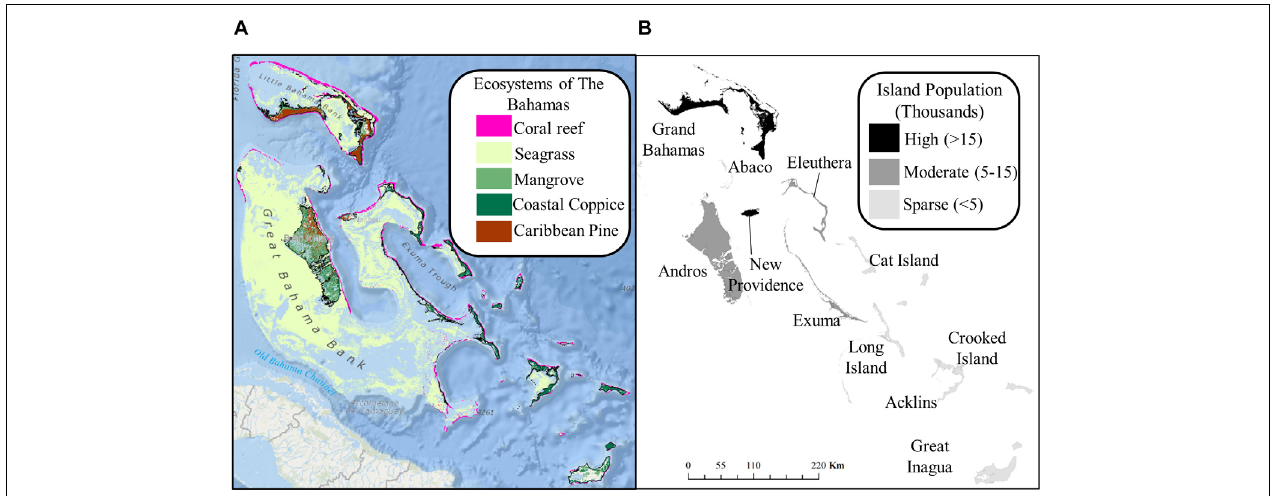
FIGURE 1 | (A) Major coastal, nearshore, and marine ecosystems of The Bahamas. (B) Islands of The Bahamas and distribution of the population. The attribution for the basemap is ESRI